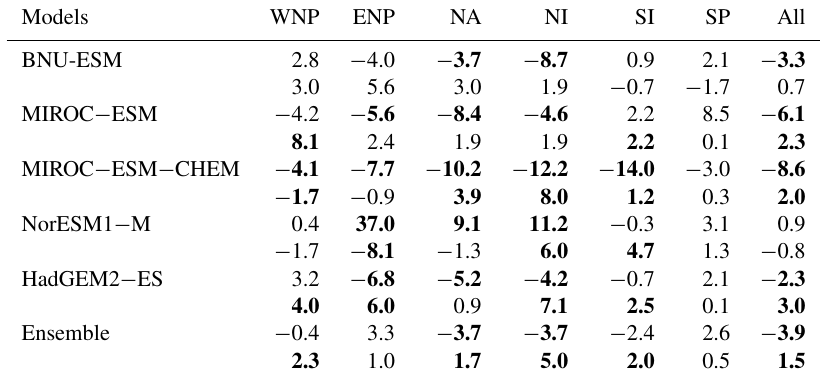
Table 4. Difference percentage in GPI and VI calculated as (G4 − RCP4.5) / RCP4.5 over the period 2020–2069 during TC season and basins. GPI are written above VI in each cell. Bold means the difference is significant at the 5% level according to the Wilcoxon signed-rank